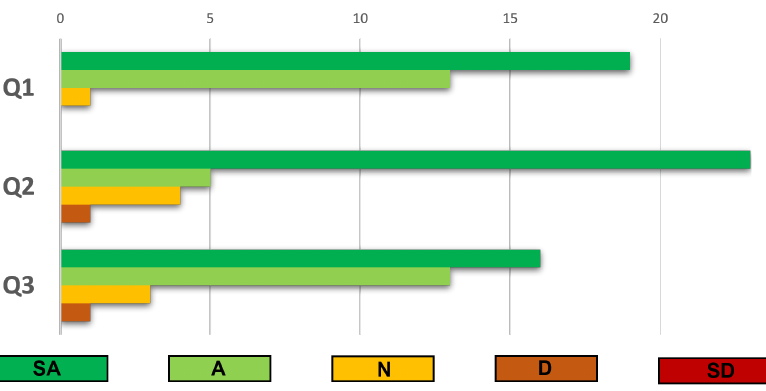
Figure 10. Answers from participants to the given questionnaire. SA = Strongly Agree, A = Agree, N = Neutral, D = Disagree, SD = Strongly